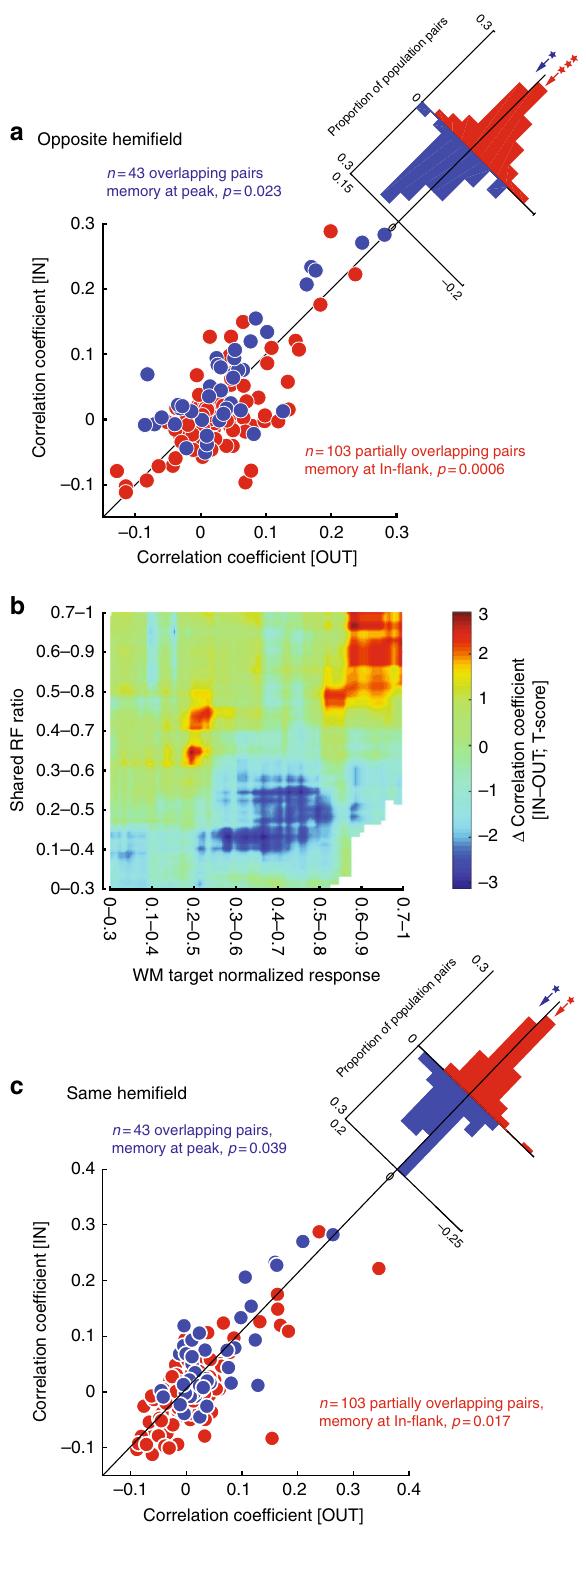
n =103 partially overlapping pairs, memory at In-flank, p =0.017